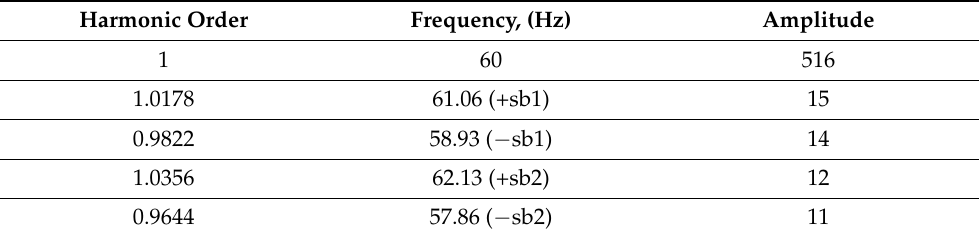
Figure 3. Simulated signal example. ( a ) Distorted signal. ( b ) Broken rotor bar harmonic components. Table 2. Simulated example signal with broken rotor bar harmonic components.